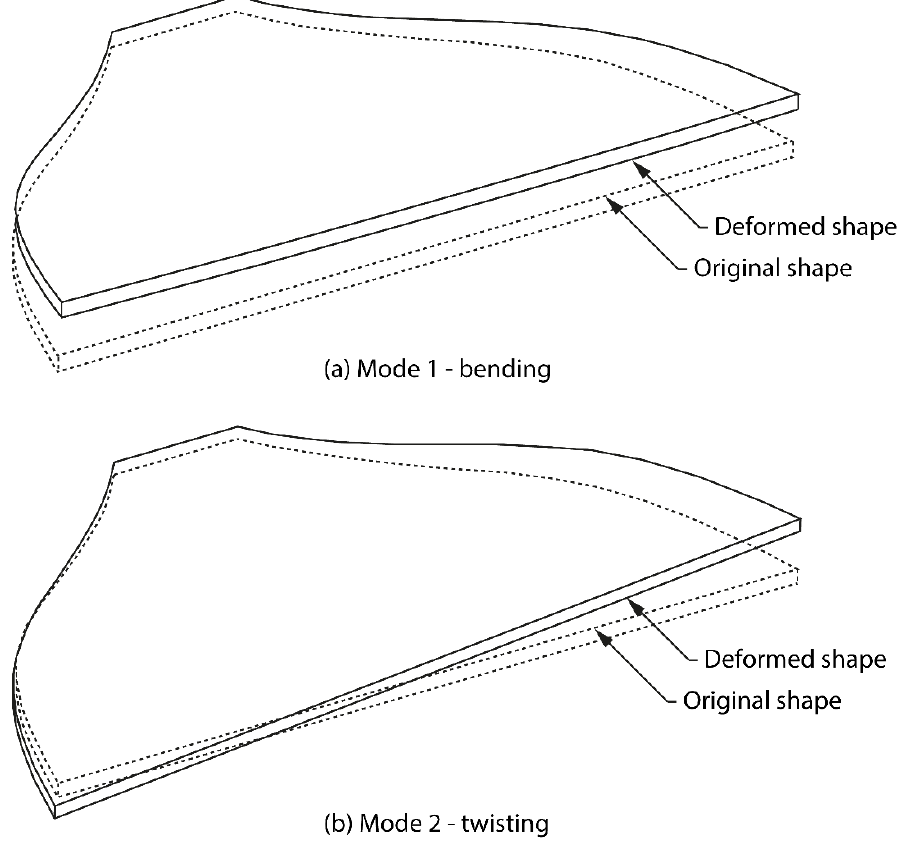
Figure 2. A schematic of ( a ) the first vibration mode, and ( b ) the second vibration mode.